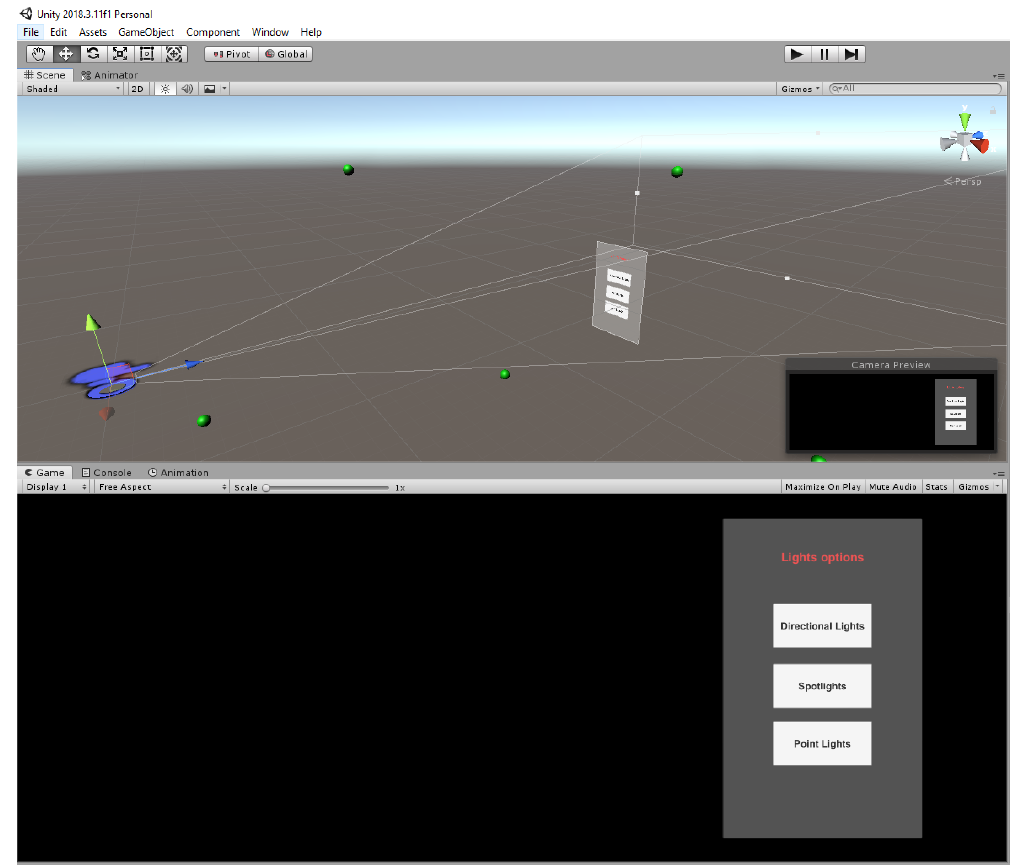
Figure 14. Light options